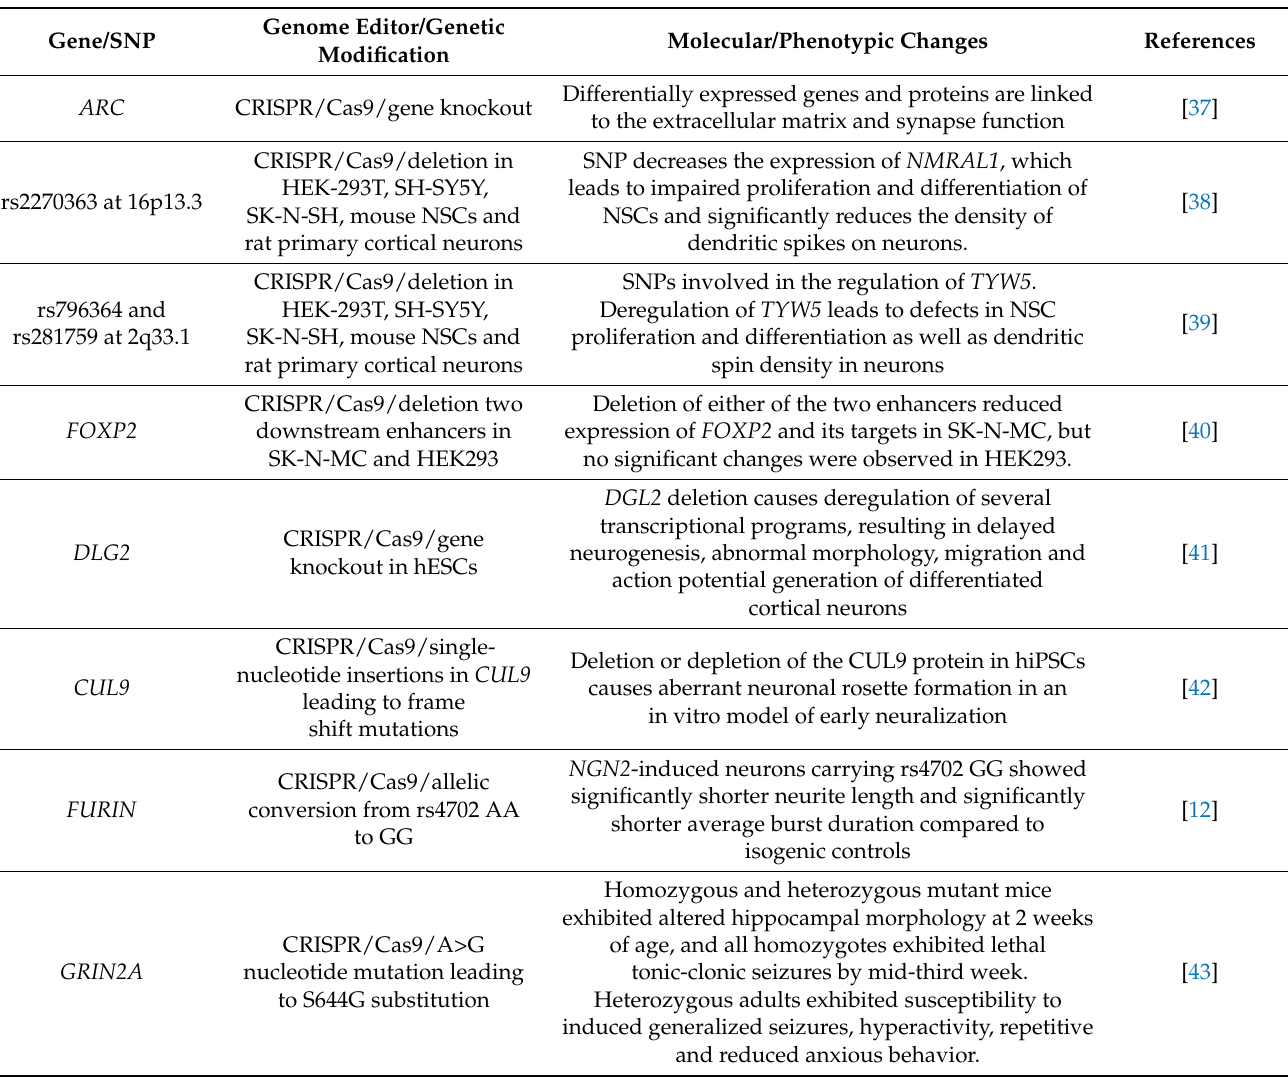
Table 1. Genes and loci associated with a high risk of developing SZ and other NDDs were investi- gated with CRISPR/Cas-based genome